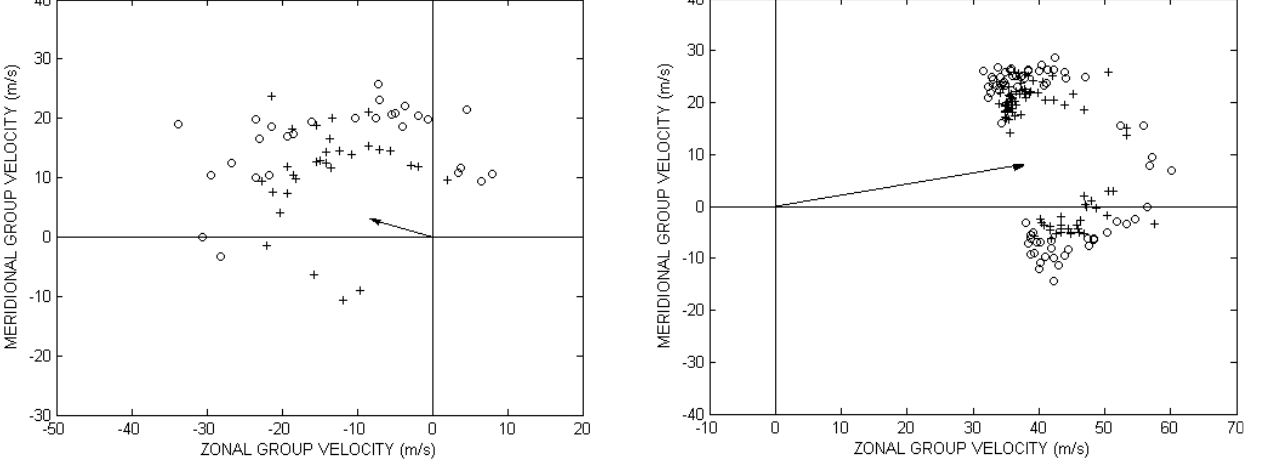
Fig.8 Scattering plot of the virtual horizontal group velocities of the upward moving Fig. 8. Scattering plot of the virtual horizontal group velocities of gravity wave packets of the winter data set. Wave packets obtained by window the upward moving gravity wave packets of the winter data set. T2Z4 were denoted by ‘cross’ ; wave packets obtained by window T2Z5 were Wave packets obtained by window T2Z4 were denoted by cross; wave packets obtained by window T2Z5 were denoted by open cir- denoted by ‘open circle’ .